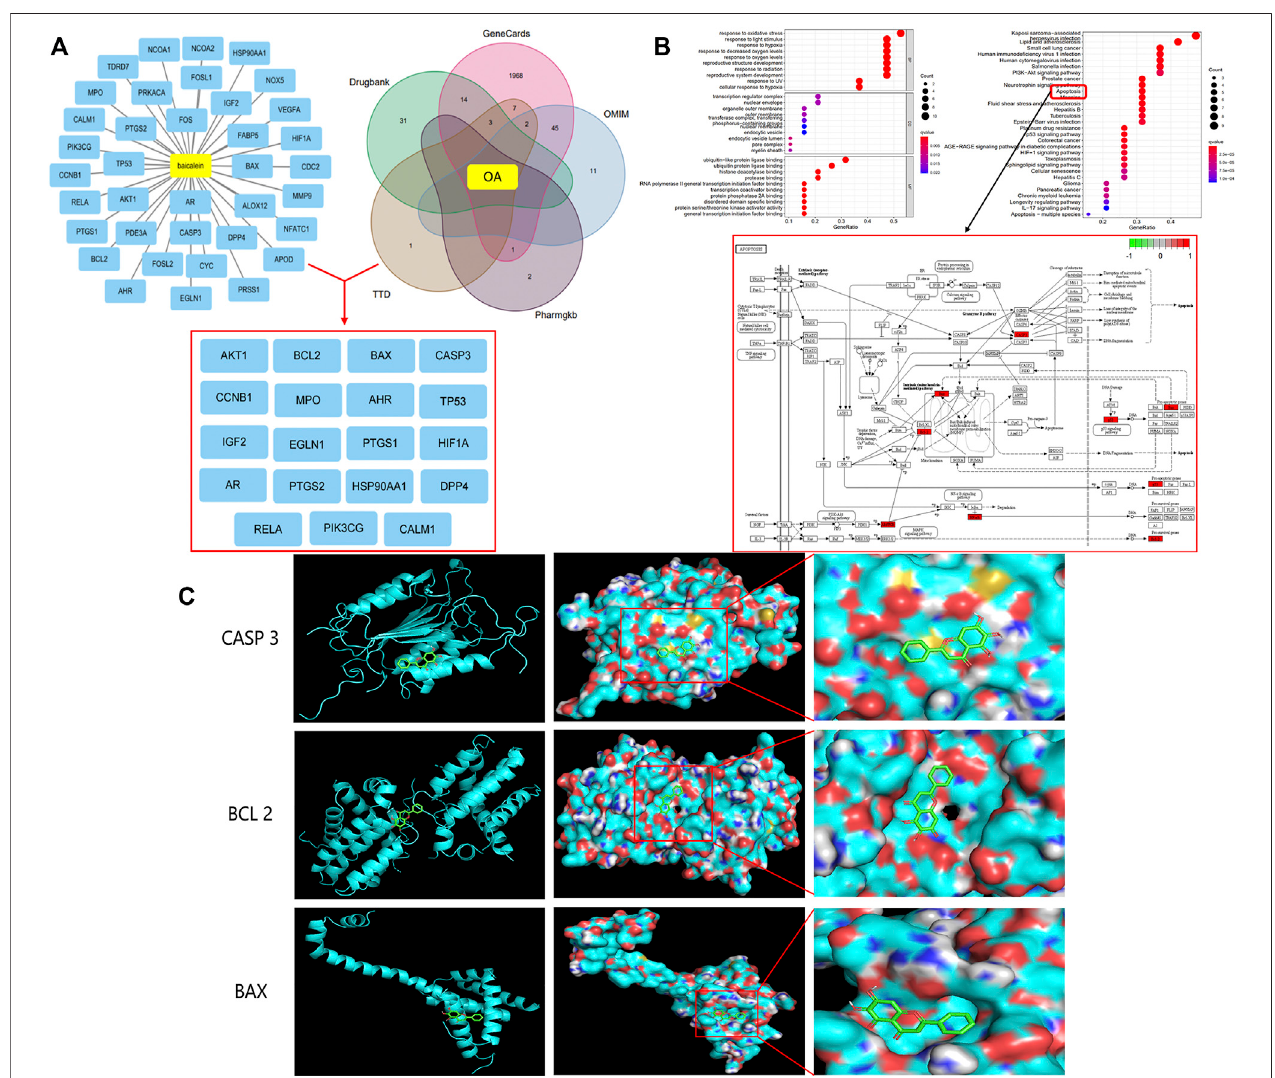
FIGURE1| Baianti-OAbyApoptoticSignalingPathway. (A) CommontargetsofOAandBai. (B) Thetop10itemsfromtheGOanalysisforbiologicalprocess(BP), cellular component (CC), and molecular function (MF). The top 30 pathways of cotargets based on KEGG enrichment analysis and six different targets were enriched in the apoptosis signaling pathway. (C) Molecular docking of Bai and BAX, BCL 2, and Caspase 3.